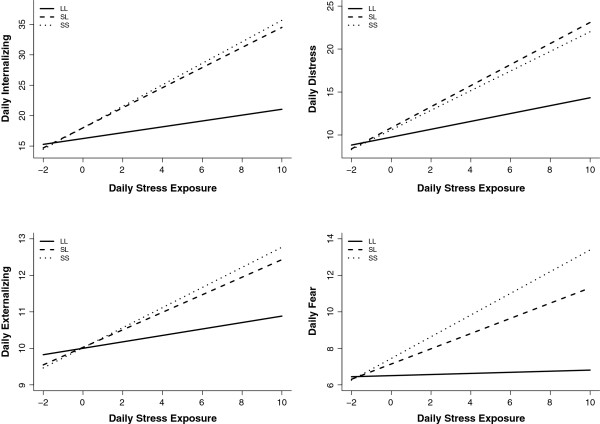
Within-person associations between daily life stress exposure and transdiagnostic symptoms as a function of 5-HTTLPR genotype. On the x-axis, the count of daily stressors is person-centered, such that 0 represents an average amount of daily stress for a given individual. LL, 5-HTTLPR long allele homozygosity; SL, 5-HTTLPR heterozygosity; SS, 5-HTTLPR short allele homozygosity.